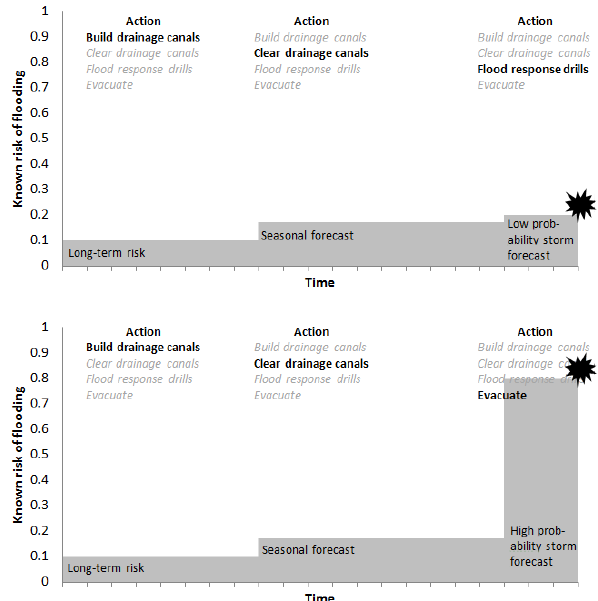
Figure 1. Idealized schematic depicting known risk of disaster im- pacts over time. Known risk of flooding increases when forecasts of rainfall are issued; the change in risk is a function of the probability of the forecasted event. Selected actions will be a function of both lead time (the difference between action based on long-term risk and seasonal risk) and the magnitude of flood risk (the difference between the far-right actions in both